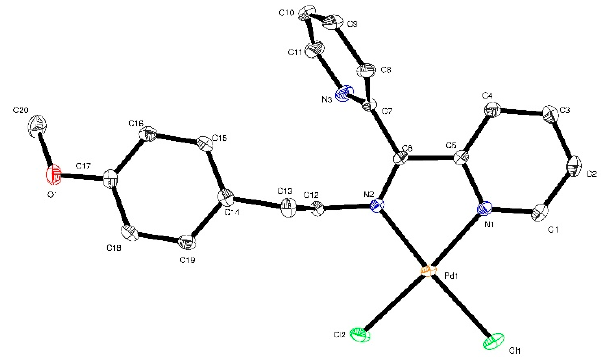
Figure 11. Crystal structure of the palladium complex 3a-Pd .